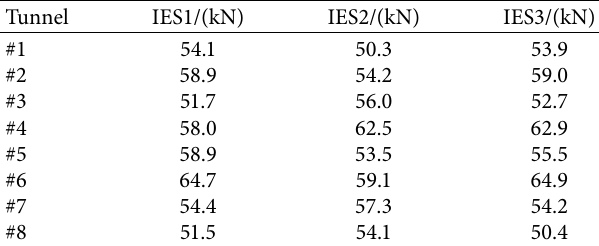
Table 6: Tensile axial forces in the bolts at the top point.